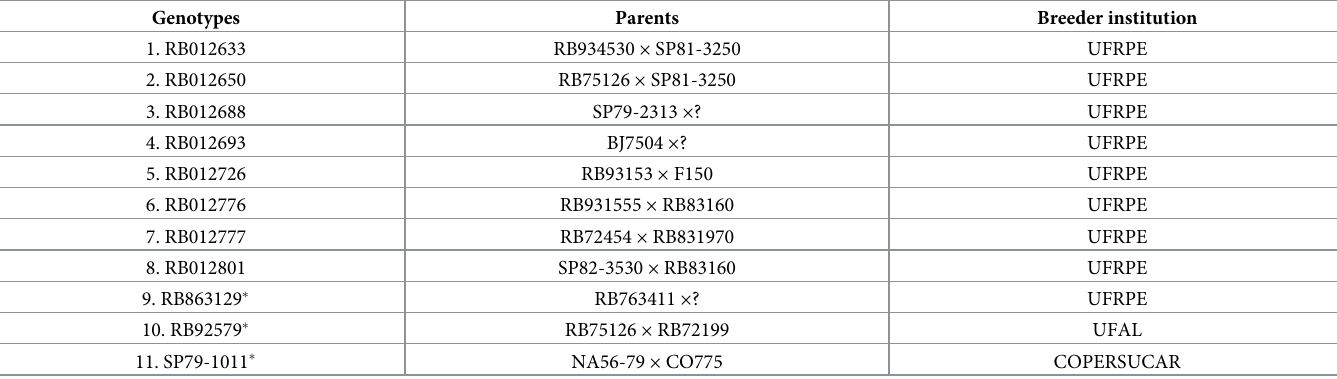
Table 2. Sugarcane clones of the RB01 series and standard cultivars used in the analysis of genetic divergence.